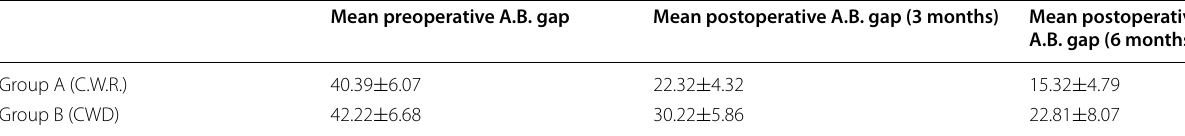
Table 4 Comparison of pre-operative A.B. gap and post-operative A.B. gap between 2 groups